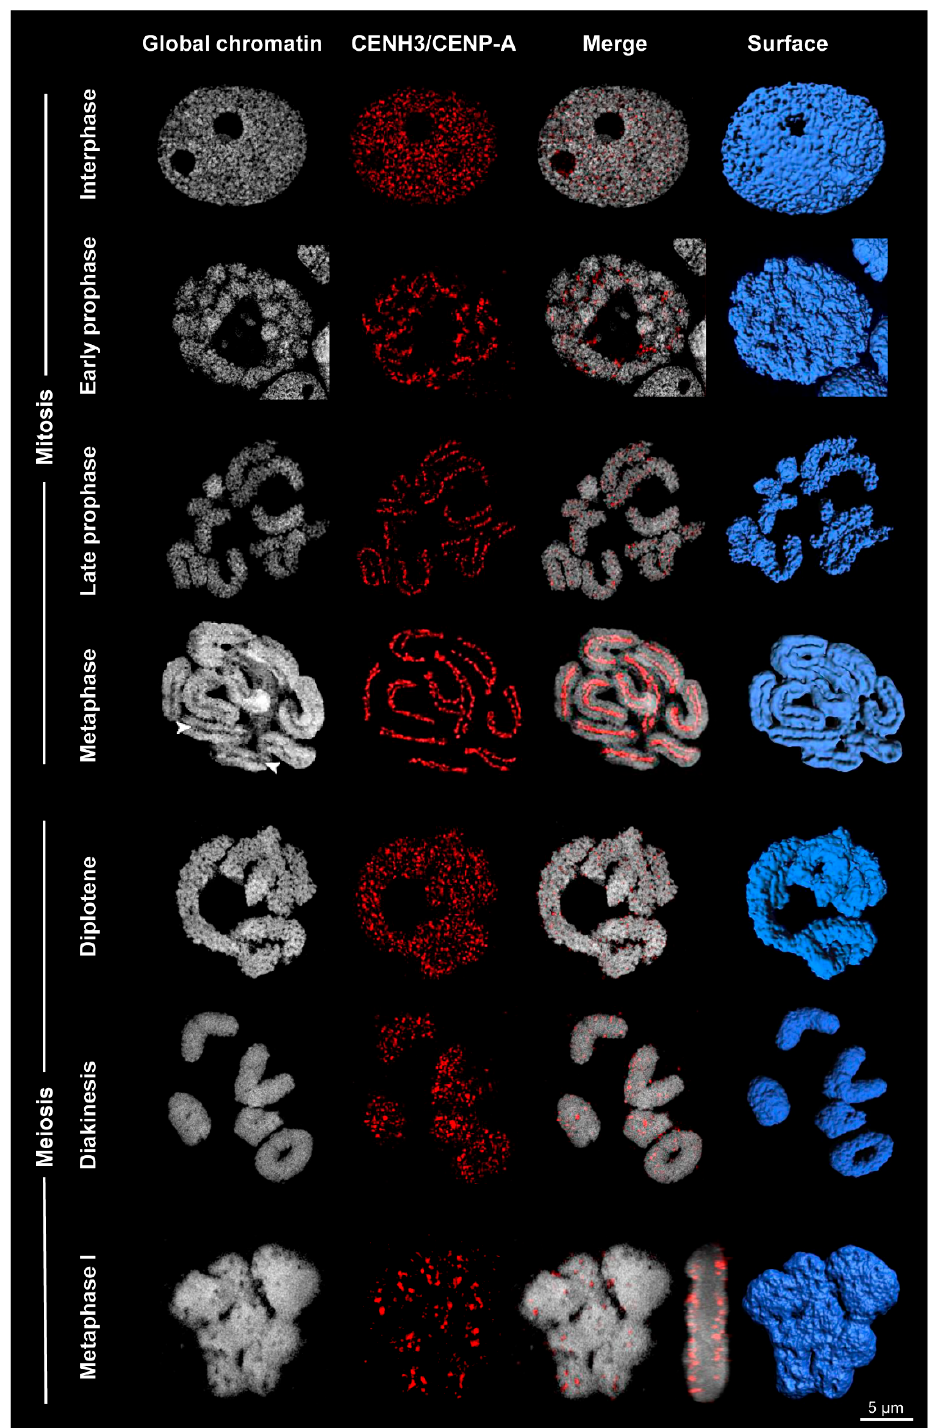
Figure 3. Centromere formation differs between mitosis and meiosis of Rhynchospora pubera. Whereas line-like holocentromeres appear in mitosis, cluster-like holocentromeres become established in meiosis. The process of global chromatin condensation and the dynamics of CENH3/CENP-A arrangement is visualized by DAPI staining and immunolabeling with CENH3/CENP-A-specific antibodies. Surface rendering of SIM image stacks clearly indicates the presence of grooves (arrowheads) at somatic metaphase chromosomes, but their absence at metaphase I bivalents. The merged side-view of the metaphase I cell reveals CENH3/CENP-A at the surface, but not inside the bivalents.